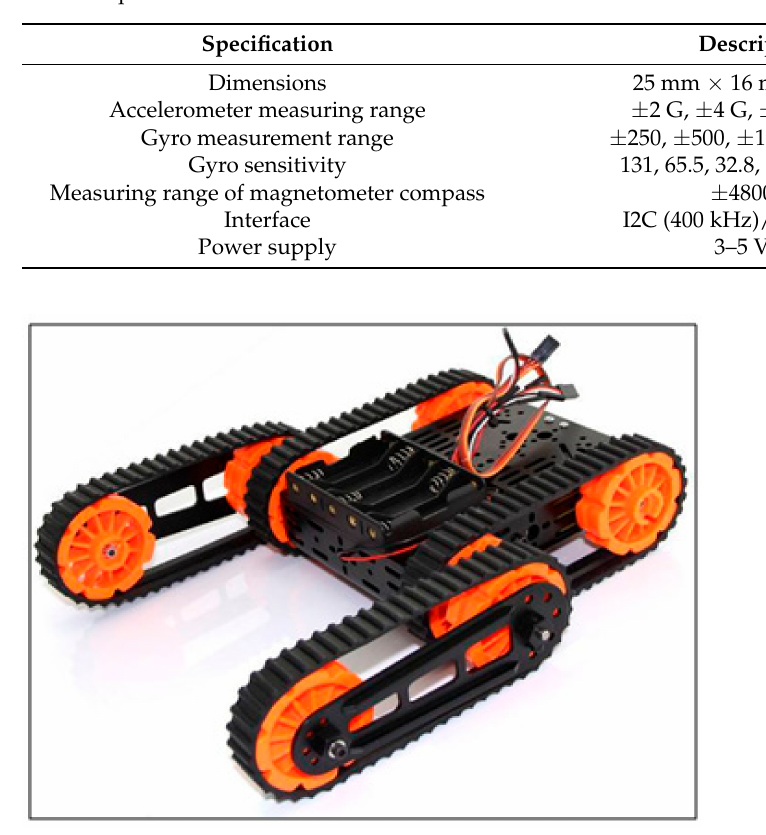
Figure 6. Multi-track